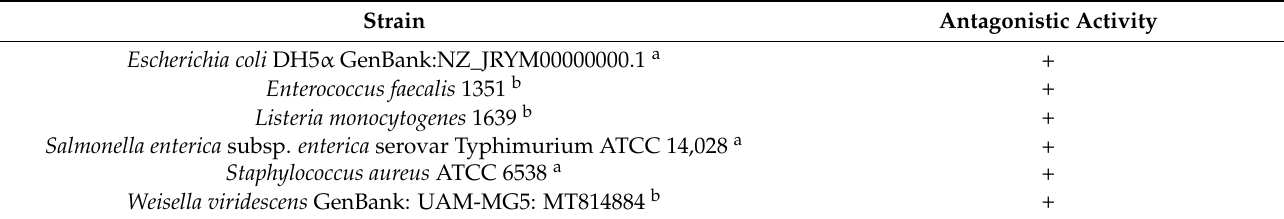
Table 1. Antagonistic activity of P . pentosaceus 1101 against different test microorganisms.